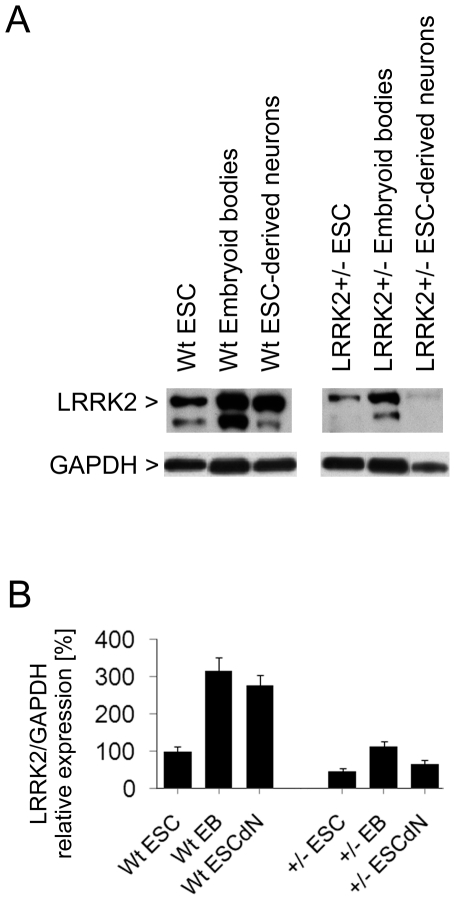
Western blot analysis of LRRK2 protein levels in cell lysates.(A) LRRK2 (and one fragment) is expressed in cultured mouse embronic stem cells (ESC), and its expression increases during retinoic acid-induced neuronal differentiation. LRRK2 levels in LRRK2+/− cells are about 50% lower than in wildtype (wt) cells. Levels of glyceraldehyde 3-phosphate dehydrogenase (GAPDH) were co-detected as gel loading controls and indicate that lower protein amounts were loaded in the LRRK2+/− ESC-derived neuron sample. The immunoblots shown are representative of three independent experiments. (B) Full-length LRRK2 protein bands were quantified by densitometry and normalized to GAPDH loading control using Quantity One software. Bars represent mean ± SD (n = 3).